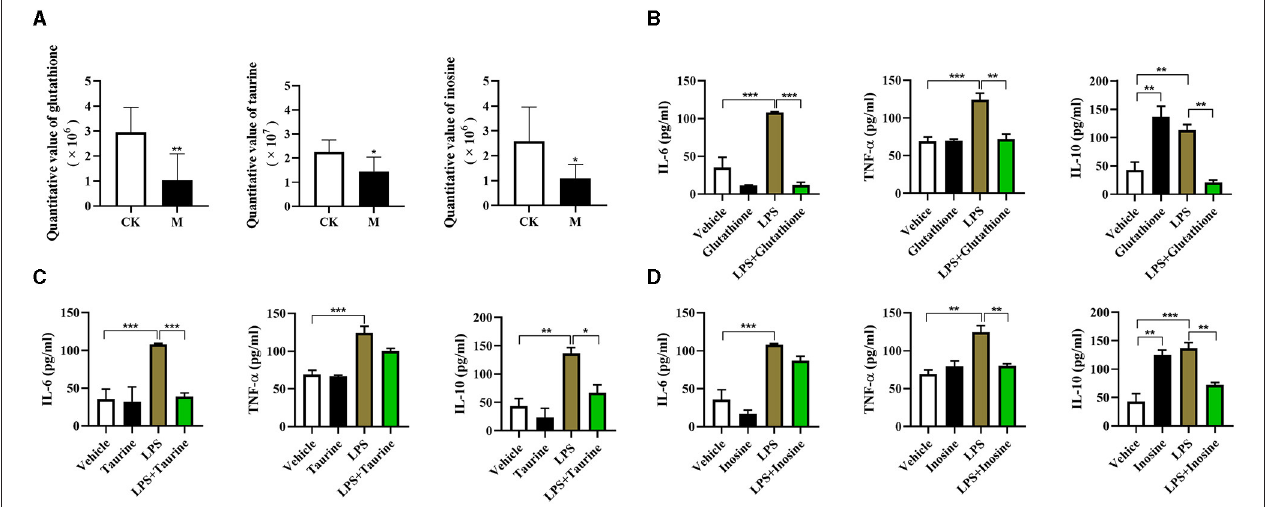
FIGURE 7 | Functional validation of differential metabolites on immune responses of splenic B cells. Glutathione (8mM), taurine (2.5mM) and inosine (5mM) were respectively added into the sorted B cells for 2h followed by 24h stimulation with LPS (10 µ g/ml), and the cytokine levels in the supernatants were determined using ELISA. (A) The quantitative value of glutathione, taurine, and inosine determined by LC/LC-MS; (B) IL-6, TNF- α , and IL-10 stimulated by glutathione; (C) IL-6, TNF- α , and IL-10 stimulated by taurine; (D) IL-6, TNF- α , and IL-10 stimulated by inosine. Values are mean ± standard error of means. CK, control check; M, model group (One-way ANOVA: * P < 0.05, ** P < 0.01, *** P <